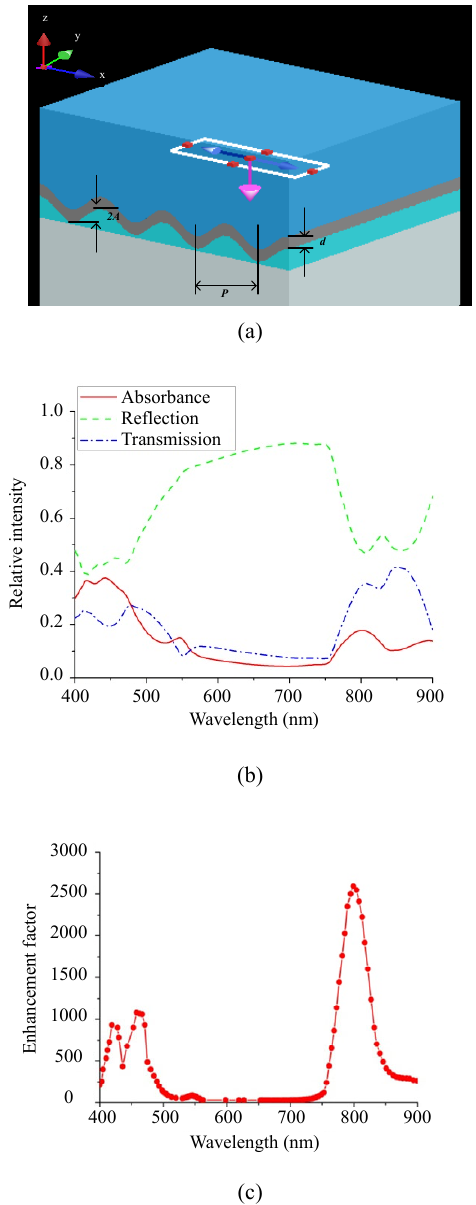
Fig. 4 Original model of the 1D sinusoidal nanograting: (a) SERS substrate based on the 1D sinusoidal Ag grating, (b) calculated absorbance, transmission, and reflection spectra of the sinusoidal Ag grating with the parameters: A = 50 nm, P = 570 nm, and d = 40 nm, and (c) simulated EF vs wavelength of excitation